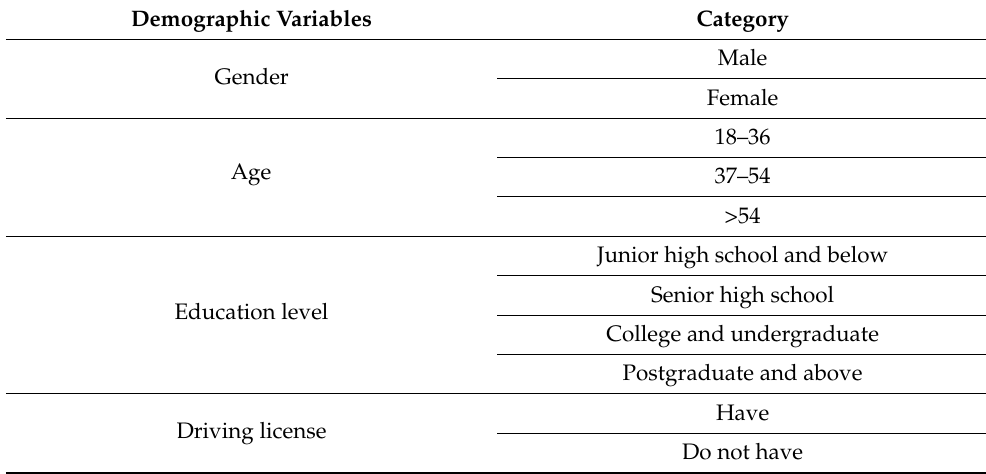
Table 1. Items of basic personal information.